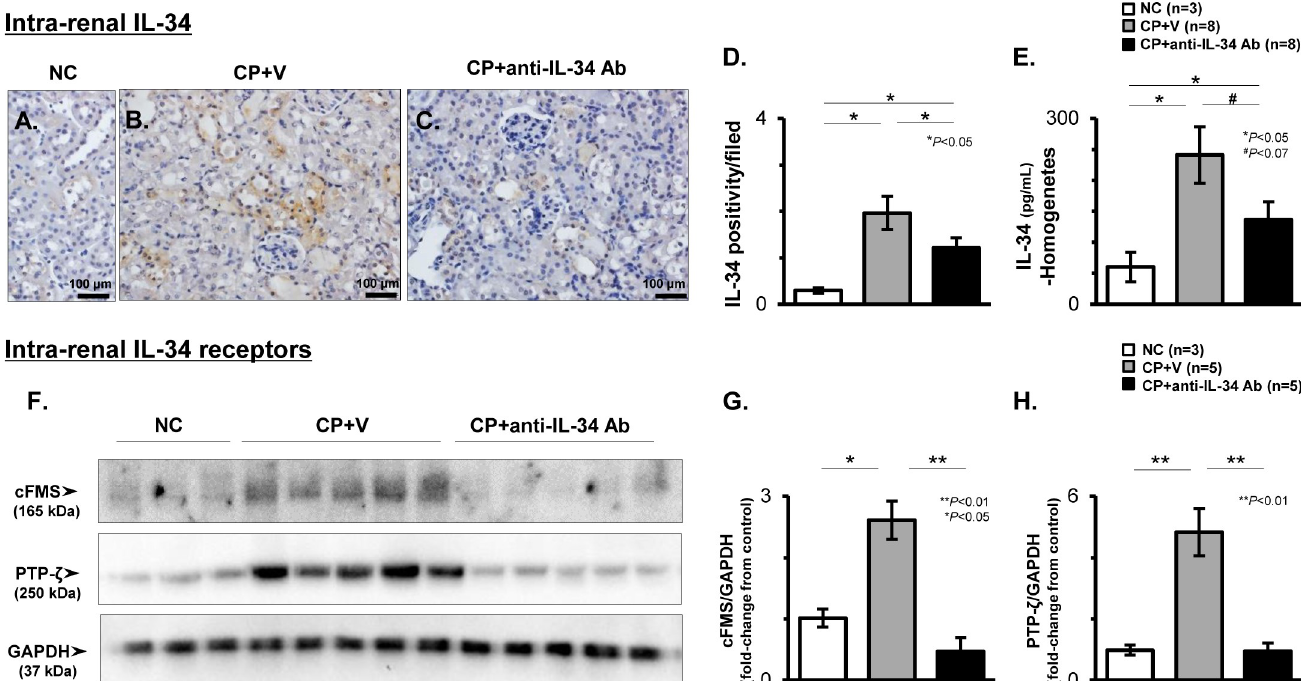
Fig 3. Intra-renal expression of IL-34 and its two receptors in CP-N mice. Representative photos of IL-34 expression on TECs identified by immunostaining among the NC ( A ), CP+V ( B ), and CP+anti-IL-34 Ab ( C ) groups of mice. Original magnification, 400 × . Graph of the IL-34 positivity among the study groups ( D ). IL-34 protein levels in homogenate kidney tissues analyzed by ELISA among the study groups ( E ). Representative WB analysis for cFMS, PTP- z , and GAPDH ( F ). Densitometric analysis of WB for cFMS ( G ) and PTP- z ( H ). The values shown are the values after normalization to GAPDH expression, and they are depicted as the relative ratio of cFMS or PTP- z to GAPDH. Data are expressed as the mean ± SEM. The Mann-Whitney U test was used for statistical analysis.